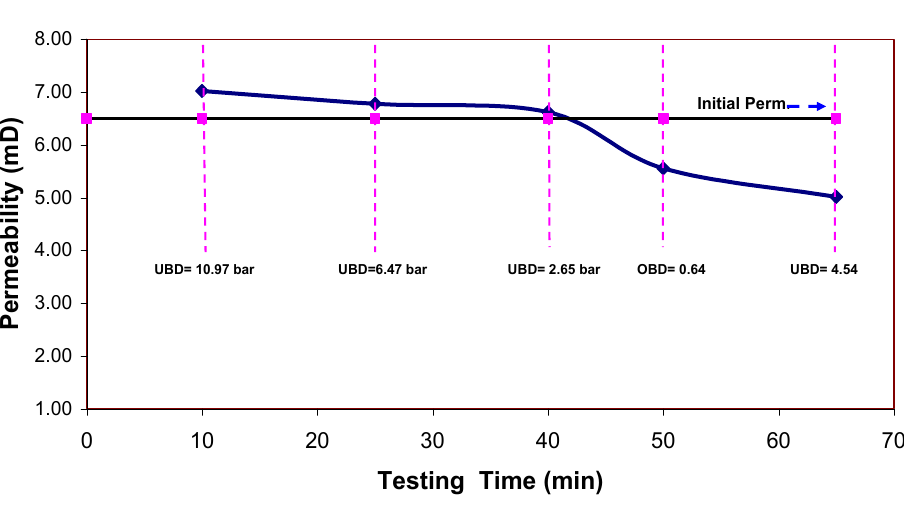
Figure 8. Monitoring of permeability during UBD leak-off test on sample D. K-Measured during UBD